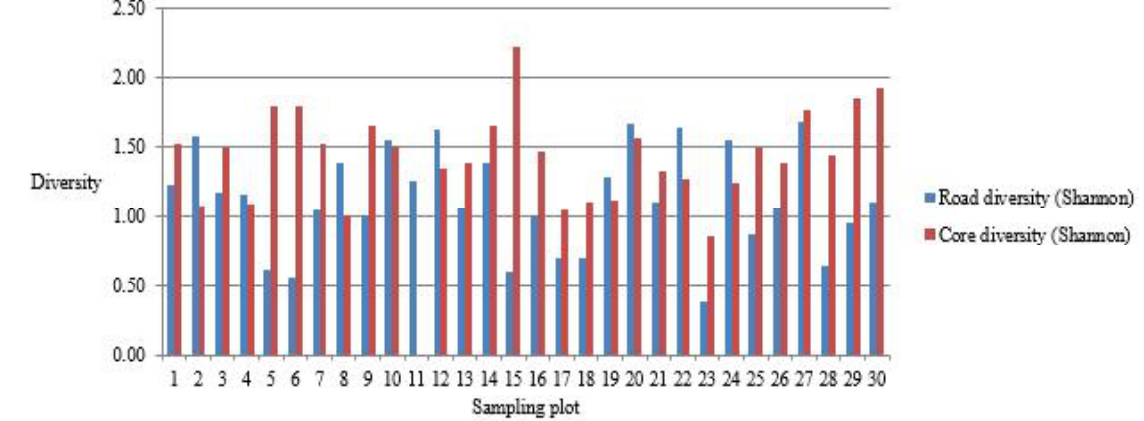
Fig. 5: Representation of ground-dwelling insects diversity at individual plots from road verge study site (blue) in comparison to those from the core area study site (red)